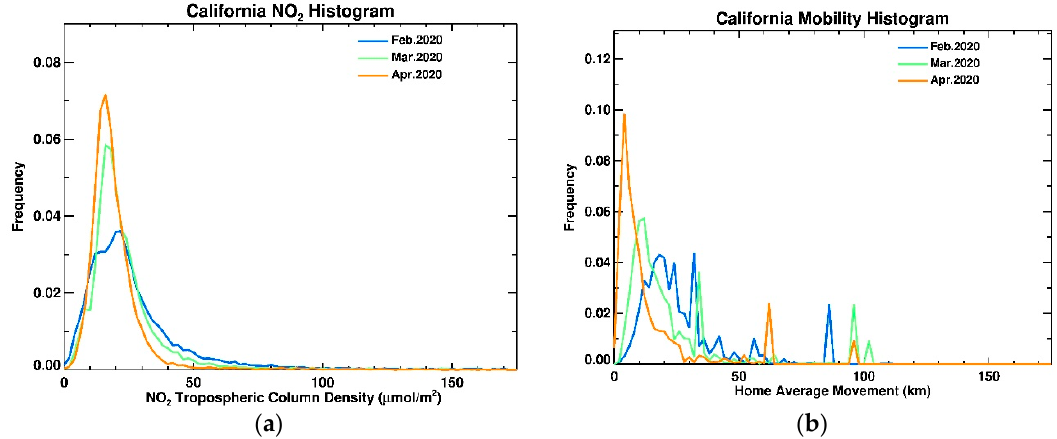
Figure 12. Histogram of NO 2 concentration in California ( a ) and mobility distribution ( b ). Chicago, Illinois had an earlier lockdown than Los Angeles. As discussed previously, the economy is focused around the downtown region by Lake Michigan in the financial and professional services sectors. However, there is a heavy manufacturing presence in the Chicago metropolitan area, particularly close to the southeastern part of Lake Michi- gan and into the western part of Indiana. As one might expect, the areas where people commute to on a regular basis showed a dramatic decrease in NO 2 in the downtown region, while the areas of heavy industry, such as powerplants and refineries, remained at elevated (though reduced) NO 2 levels (Figure 13). A recent study [44] reported that reductions in NO 2 as observed by TROPOMI due to the lockdown were ~14% for 15 March to 30 April 2020 compared to the same time in 2019. ( a )